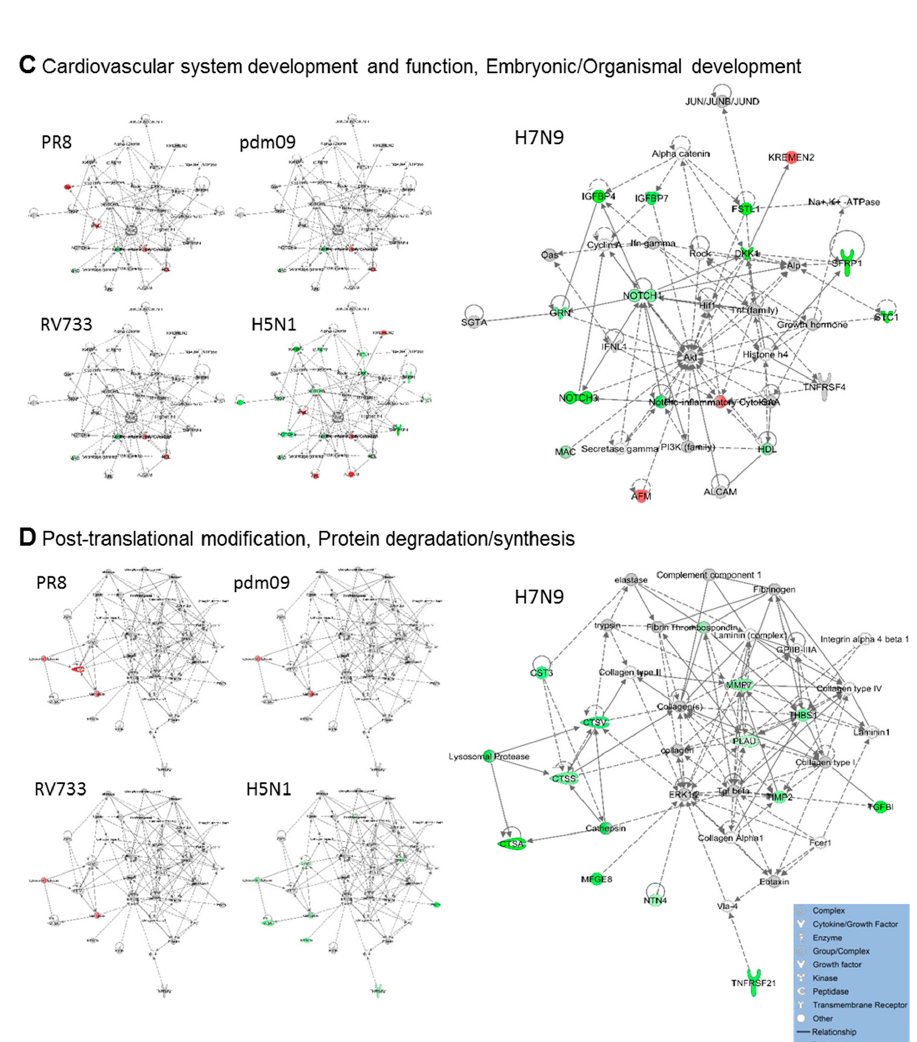
Figure 3. Significant differentially regulated A549 protein networks. A – D correspond to indicated IPA-defined Networks. Proteins and their levels of regulation were imported into the IPA ® tool and interacting pathways were constructed under default settings. Four of the top dysregulated A549 cell networks that contain 12 or more “focus” molecules (molecules significantly up- or downregulated) and that have network scores ≥ 20 are depicted. Red: Significantly upregulated proteins; Pink: moderately upregulated proteins; Gray: proteins within the SOMAscan panel, but whose expression was not significantly up- or downregulated by indicated infection; Light Green: moderately downregulated proteins; Dark Green: significantly downregulated proteins; White: proteins known to be in network, but not covered within SOMAscan panel. Dashed lines represent predicted or indirect interactions; solid lines represent direct known interactions.